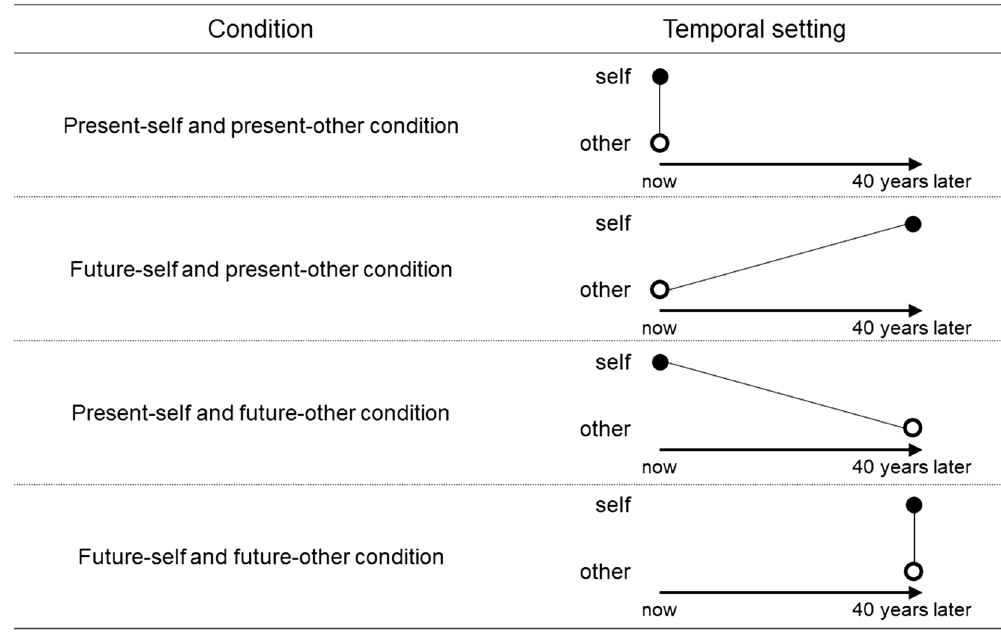
Figure 1. The temporal difference between self and other in each condition. Black dots represent self, and white dots represent other.